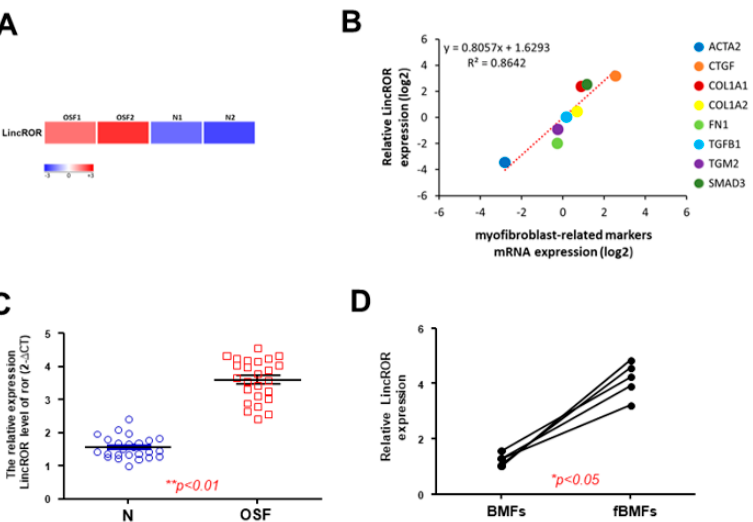
Figure 5. LincROR is upregulated in OSF specimens and positively correlated with various fibrosis markers. ( A ) A heatmap showing LincROR was highly expressed in two OSF tissues. ( B ) LincROR was positively associated with the indicated fibrosis-related markers. ( C ) Gene expression of LincROR in OSF samples and normal buccal mucosal tissues ( n = 25). ( D ) Gene expression of LincROR in BMFs and fibrotic BMFs derived from OSF tissues. ∗ p < 0.05 compared to control. ** p < 0.01.